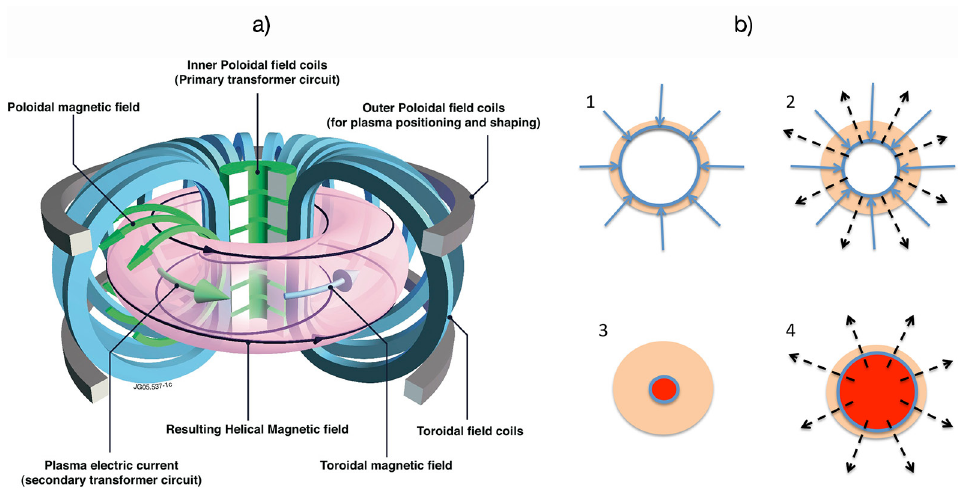
Fig. 2. – (a) Magnetic confinement geometry illustrated for the tokamak configuration —see text (courtesy EUROfusion). (b) 1: Inertial confinement geometry. The shell target (blue circle) is irradiated with the driver beams (blue arrows) and a spherical cloud of ablated plasma is formed. 2: The shell implodes as a consequence of ablation. 3: A hot spot of compressed fuel is formed where fusion reactions take place. 4: The fuel is burned and an explosion